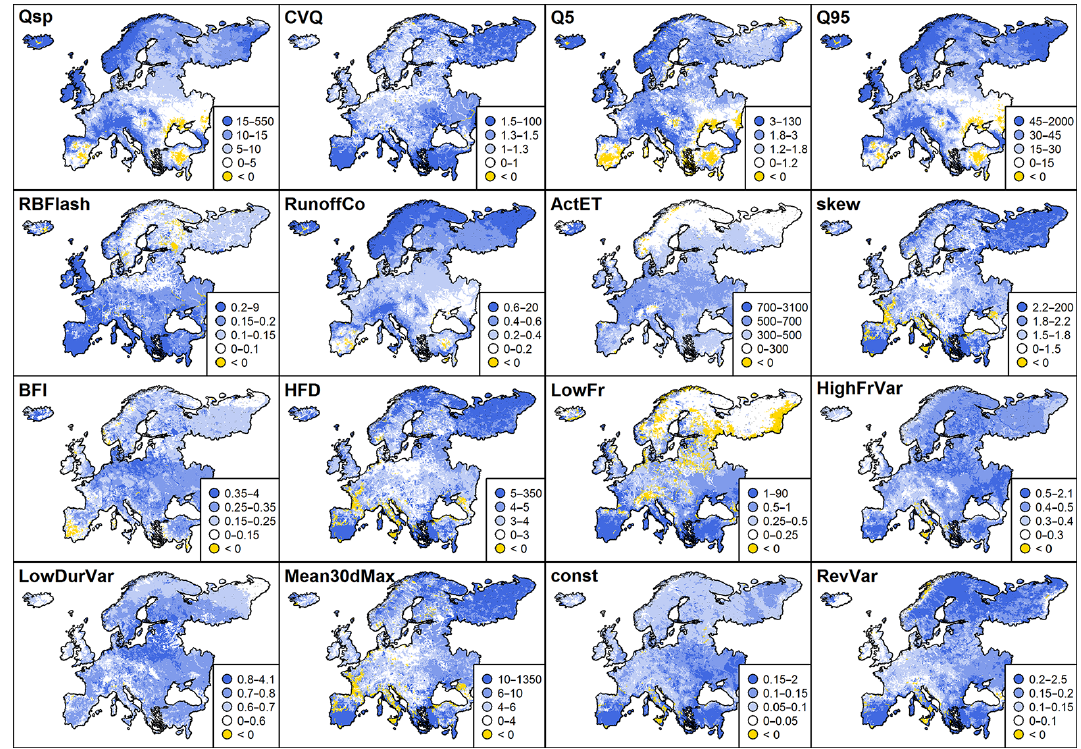
Figure 8. Predicted flow signatures using the regression models calibrated within classes of the CART classification (Fig. 3c). Note that the color intervals are adapted to each signature and do not have a constant size for a given signature: for a better readability they are based on the quartiles of the signature distribution. The coefficients of determination of these models are shown in Fig.